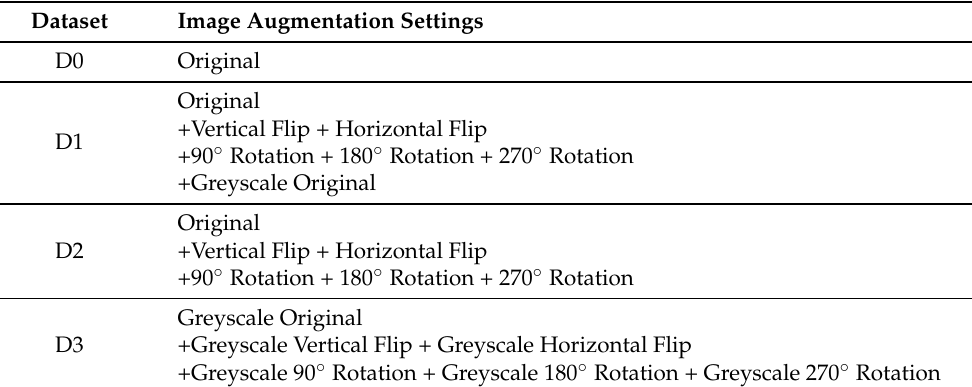
Table 3. Image augmentation settings of each dataset.